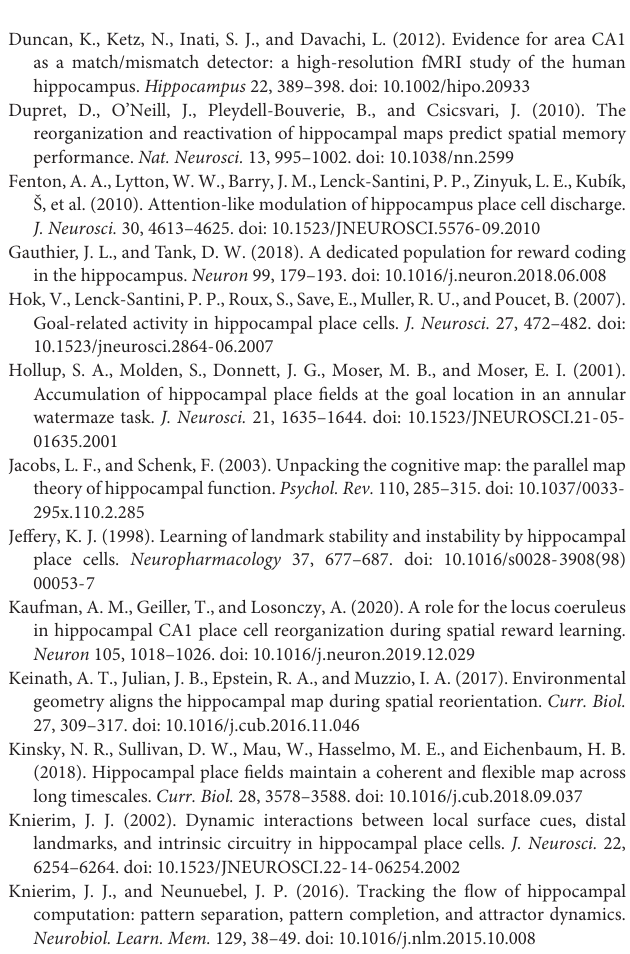
Supplementary Figure 1 | Rate maps of co-recorded neurons from Ensemble 1 (RwdFlav). Rate maps of all the neurons present in Ensemble 1 across STD and MIS sessions from Rat-113. Ensemble 1 has 27 co-recorded neurons. The number inside the firing rate maps indicates the peak firing rate in Hz.